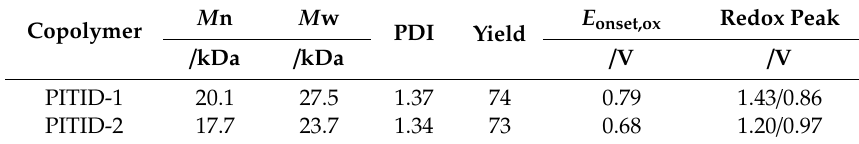
Table 1. Electrochemical data and molecular weights of the PITID-1 and PITID-2.